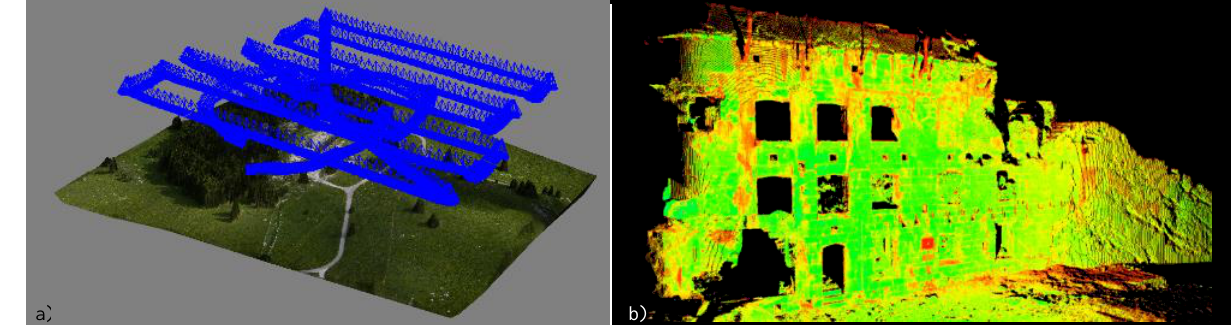
Figure 3. (a) UAV photogrammetric survey network on the Verle fort. (b) Laser scanner data (Leica HDS7000) of Vezzena fort.